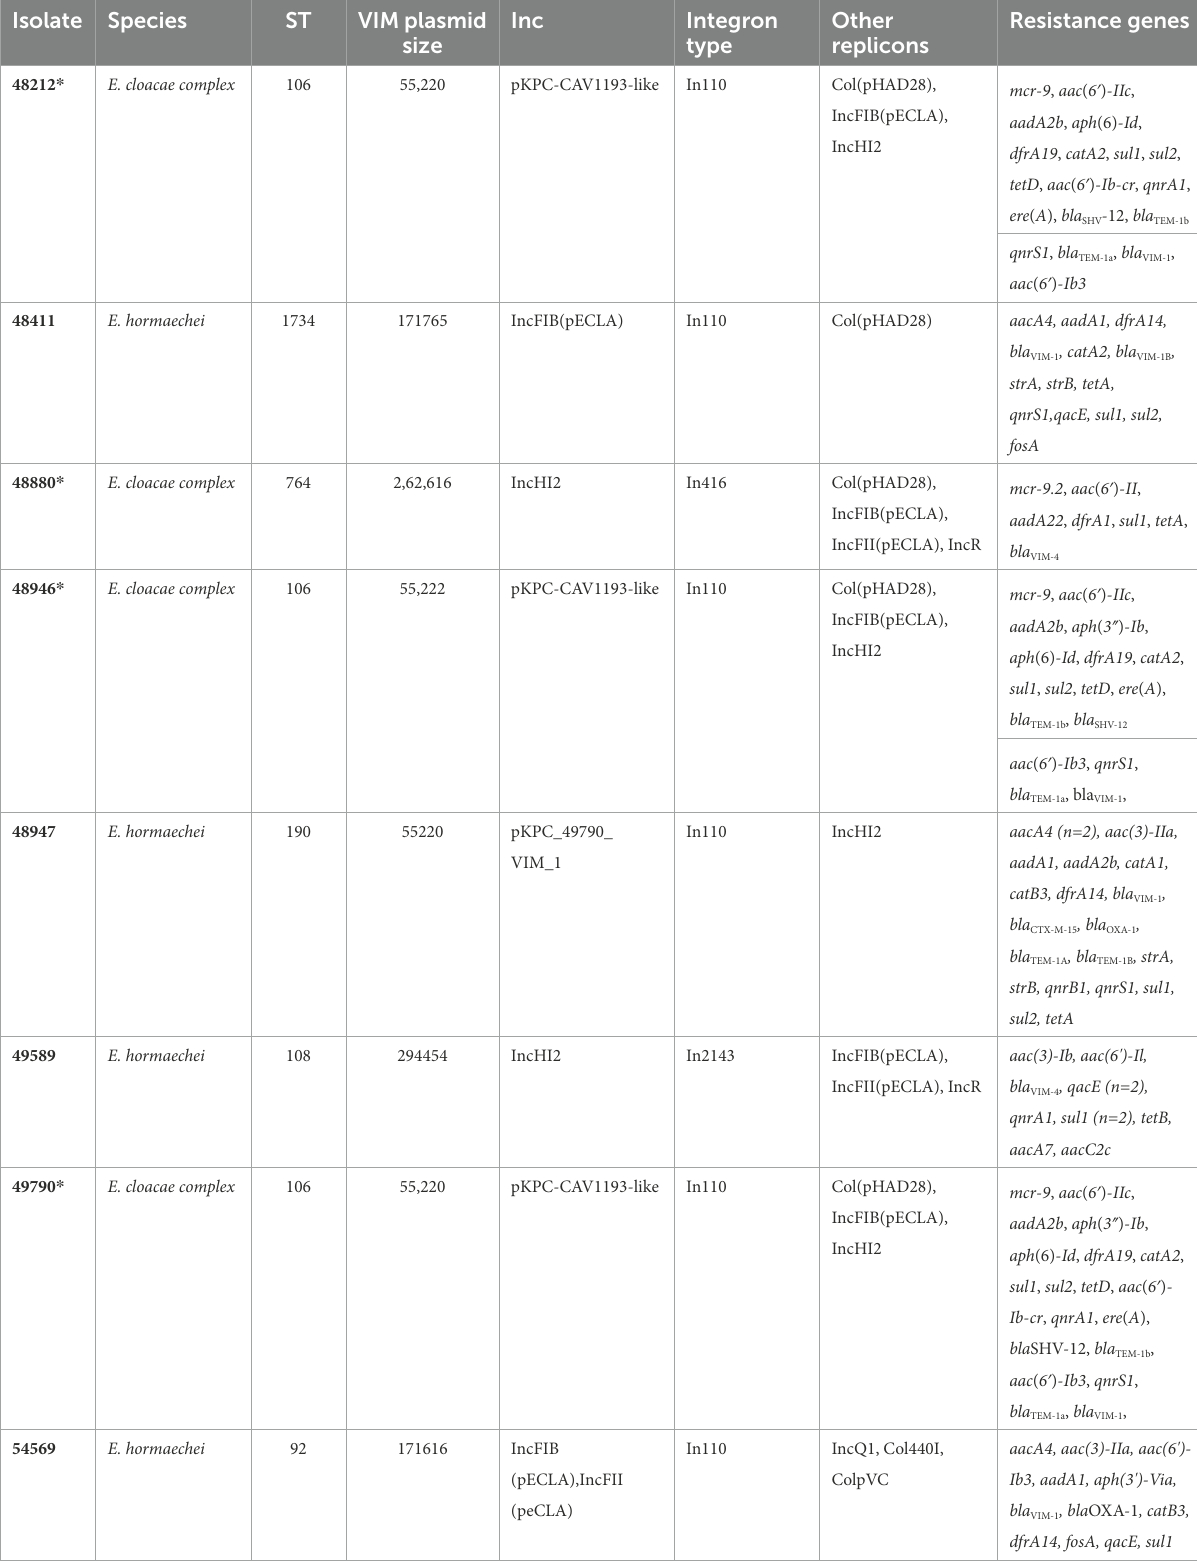
TABLE 1 WGS data of the 19 isolates sequenced using both short (illumina) and long reads sequencing platform (PacBio).